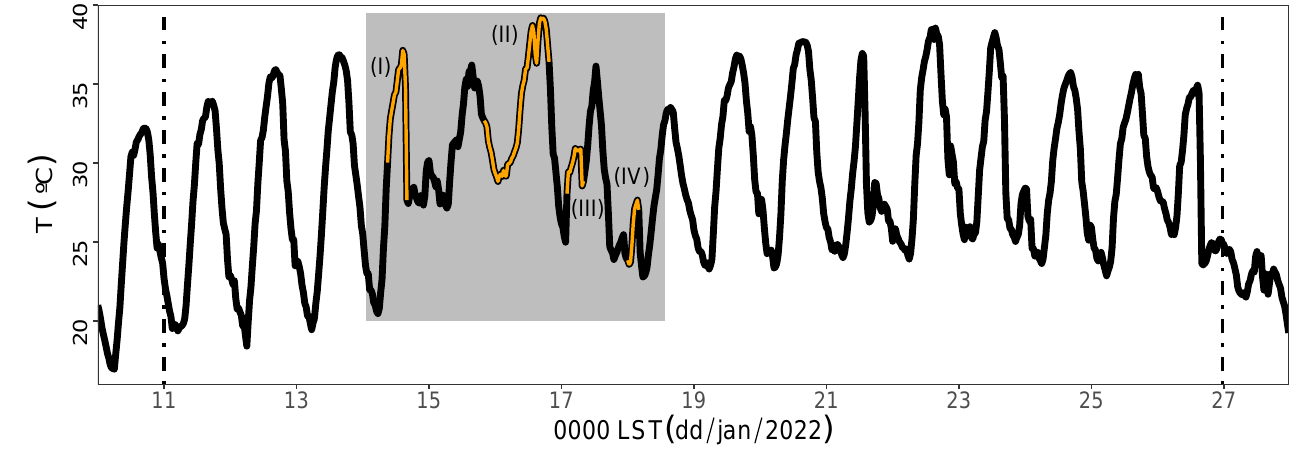
Figure 5. Time series of 3 m air temperature ( T ; black line) in the period from 10 to 27 January 2022. The orange lines highlight periods representing the DWs episodes (I–IV). The vertical dashed lines correspond to the beginning (11 January 2022) and demise (26 January 2022) of the HW, while the grey shaded area indicates the period from 14 to 18 January 2022 that was affected by the